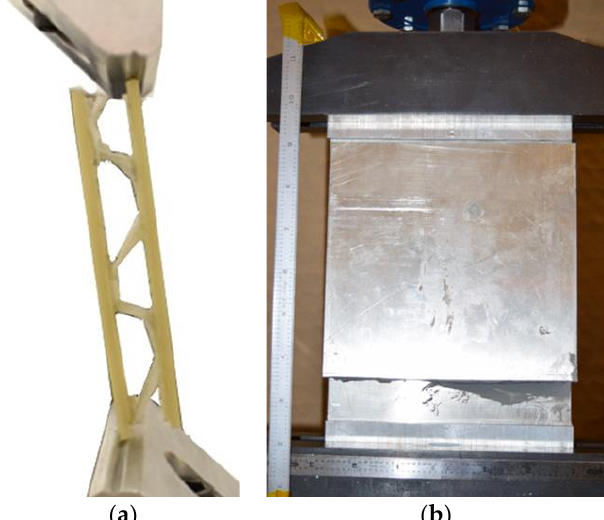
Figure 18. Sandwich Shear Modulus Testing Configuration, (a) representative specimen geometry showing shear loading configuration, (b) as-tested configuration showing aluminum loading plates bonded to the composite facesheets.